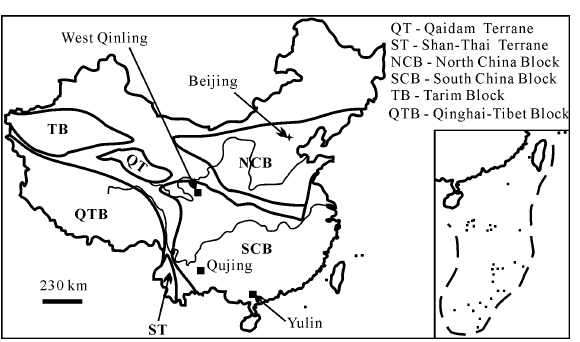
Fig. 1. Sketch map showing the Chinese tectonic units and the location of the Yulin area, Guangxi Province (revised from Zhao & Zhu 2010).